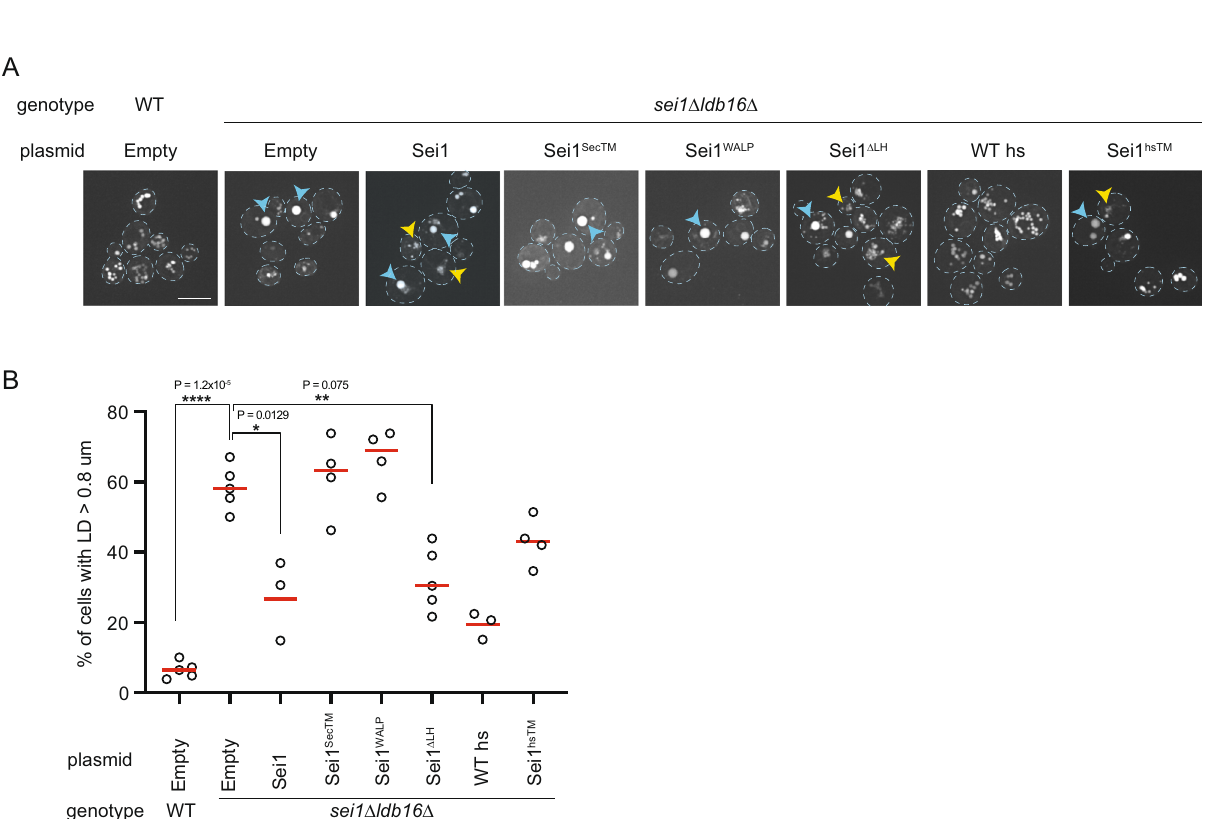
Fig. 4 Sei1 Locking Helix positions transmembrane segments and facilitates Ldb16 binding. A Sei1 protomer model shown (left) in the context of the map at low contour (level of 0.005) within detergent micelle or (middle) without map overlay. Inset (right) depicts the locking helix (LH, green) and TM1 and TM2 (pink). The LH M240 (yellow) establishes methionine-aromatic interaction with Y37 and Y41 (red) in TM1. B Analysis of LDs in cells with the indicated genotype after staining with the neutral lipid dye BODIPY 493/503. Scale bar corresponds to 5 µ m. C Quanti fi cation of LD diameter of cells shown in ( B ). At least 100 LDs were analysed for a minimum of 3 biological repeats. Red bars represent median diameter. n = 3. Difference in distribution of LD size was tested using a two sided Kolmogorov-Smirnov test (**** p < 0.0001, n.s . non-signi fi cant). D Schematic representation of the angle ( a ) between Sei1 TM1 and TM2 analyzed by atomistic MD simulations in ( E ). E Computed angles between TMs 1 and 2 during 3 × 120 ns atomistic MD simulations of Sei1, Sei1 Δ LH and Sei1 LL with the fi rst 20 ns discarded as equilibration. The data has been binned into 1D histograms (thin line) with a line fi tted through the bin centers and smoothed using a Savitzky-Golay fi lter with a step of 5 (thick line). F Cryo-EM map of Sei1 Δ LH homodecamer shown as side view (top), depicting luminal domain protein density (contour level of 0.05) with each Sei1 protomer colored in shades of blue, and the surrounding detergent micelle shown in transparent gray (contour level of 0.005) or 90-degree rotated view looking down from the cytosol (bottom), with detergent micelle omitted for clarity. G Structural alignment of the luminal domains of Sei1 (light blue) and Sei1 Δ LH (dark blue).